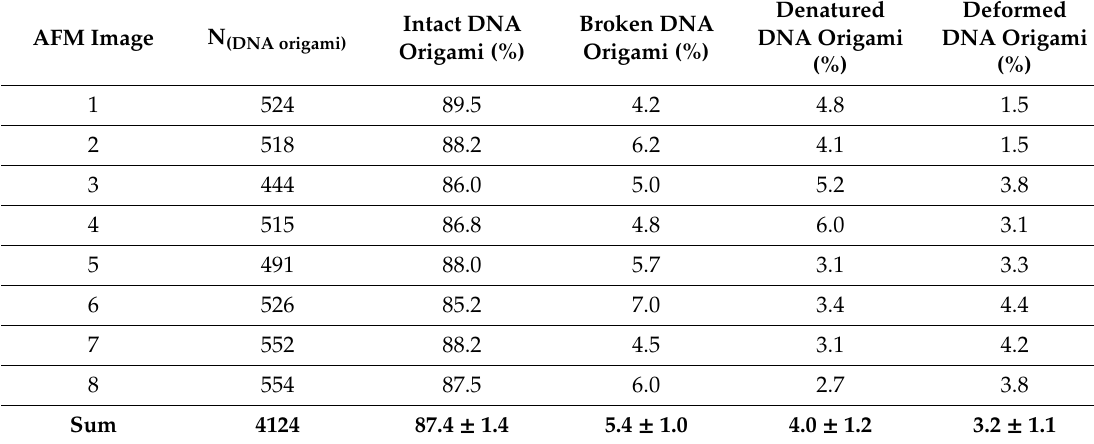
Table 1. Number of analyzed DNA origami triangles (N (DNA origami) ) for each of the eight AFM images recorded after dip-washing a sample assembled from 38-month-old staples and the corresponding yields of intact, broken, deformed, and denatured DNA origami in %. AFM Image N (DNA origami)